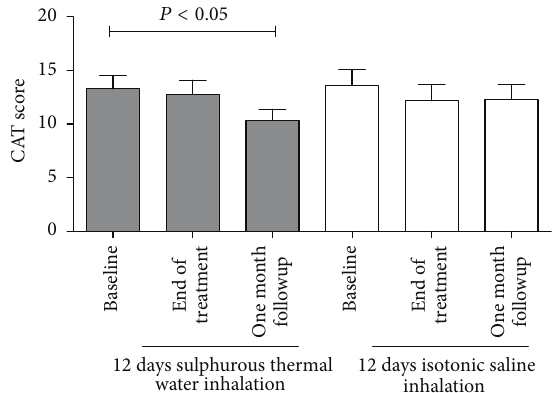
Figure 4: COPD Assessment Test (CAT) questionnaire in COPD patients at the baseline, at the end of the inhalation treatment, and one month after the end of the treatment.